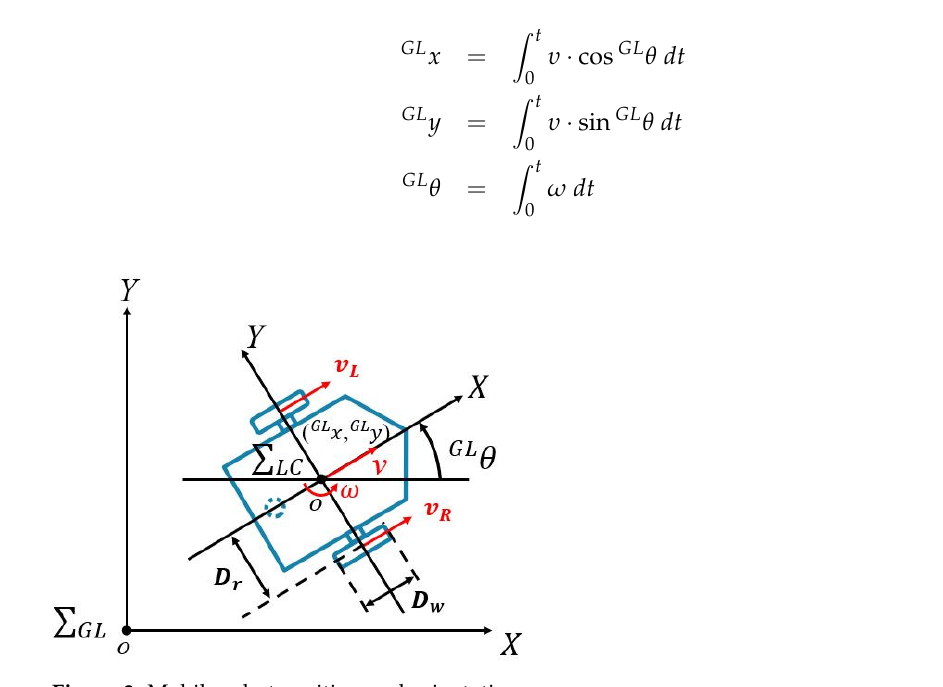
Figure 3. Mobile robot position and